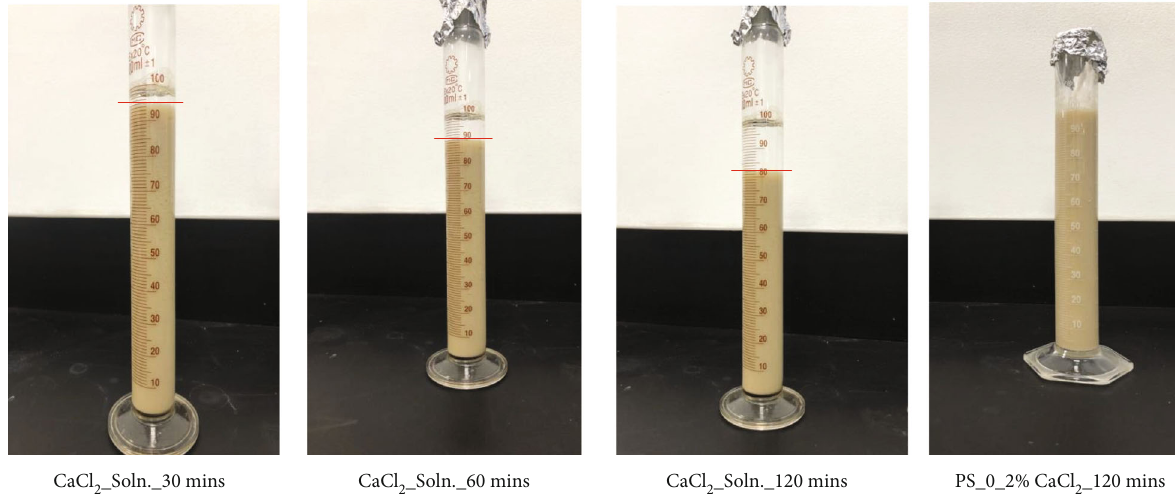
Figure 5: Stability of bentonite in CaCl